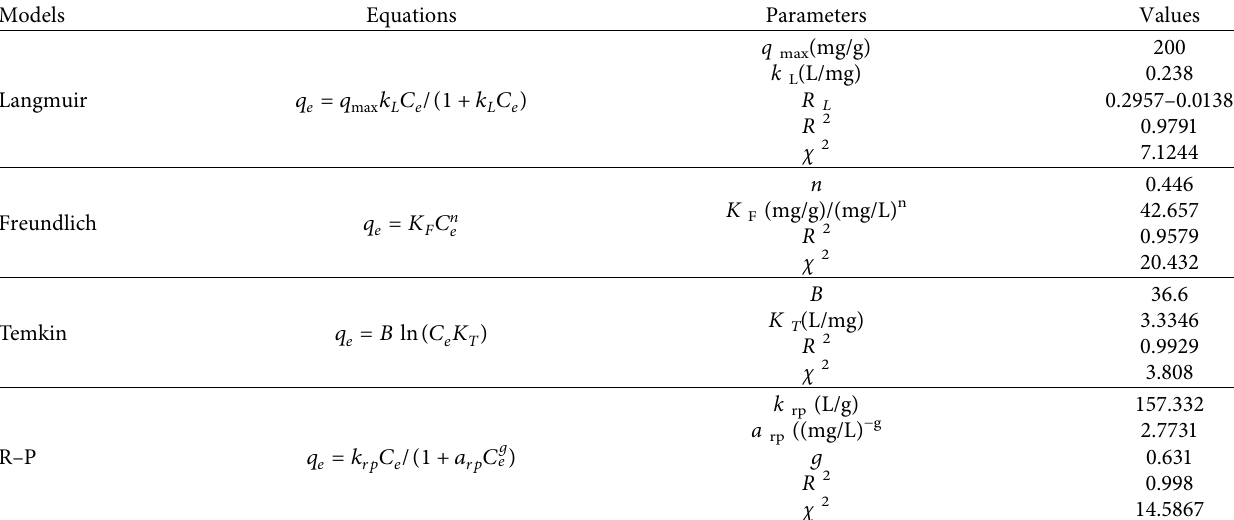
Table 6: Isotherm constants and their correlation coefficients for the adsorption of MB by UV/n-GO (agitation time � 40min, pH � 6, dosage � 0.4g/L, and temperature � 303K). Models